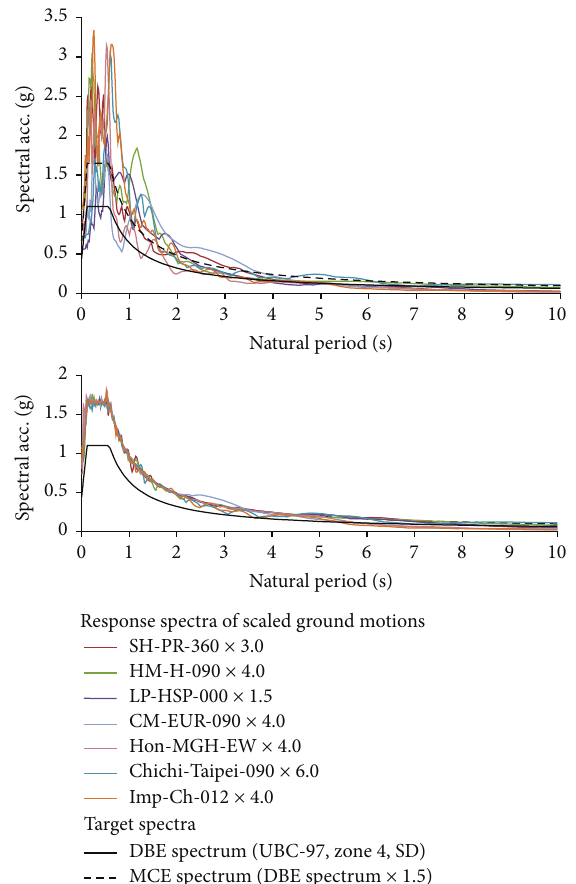
Figure 2: Comparison of the matched spectra of the ground motions with DBE and MCE